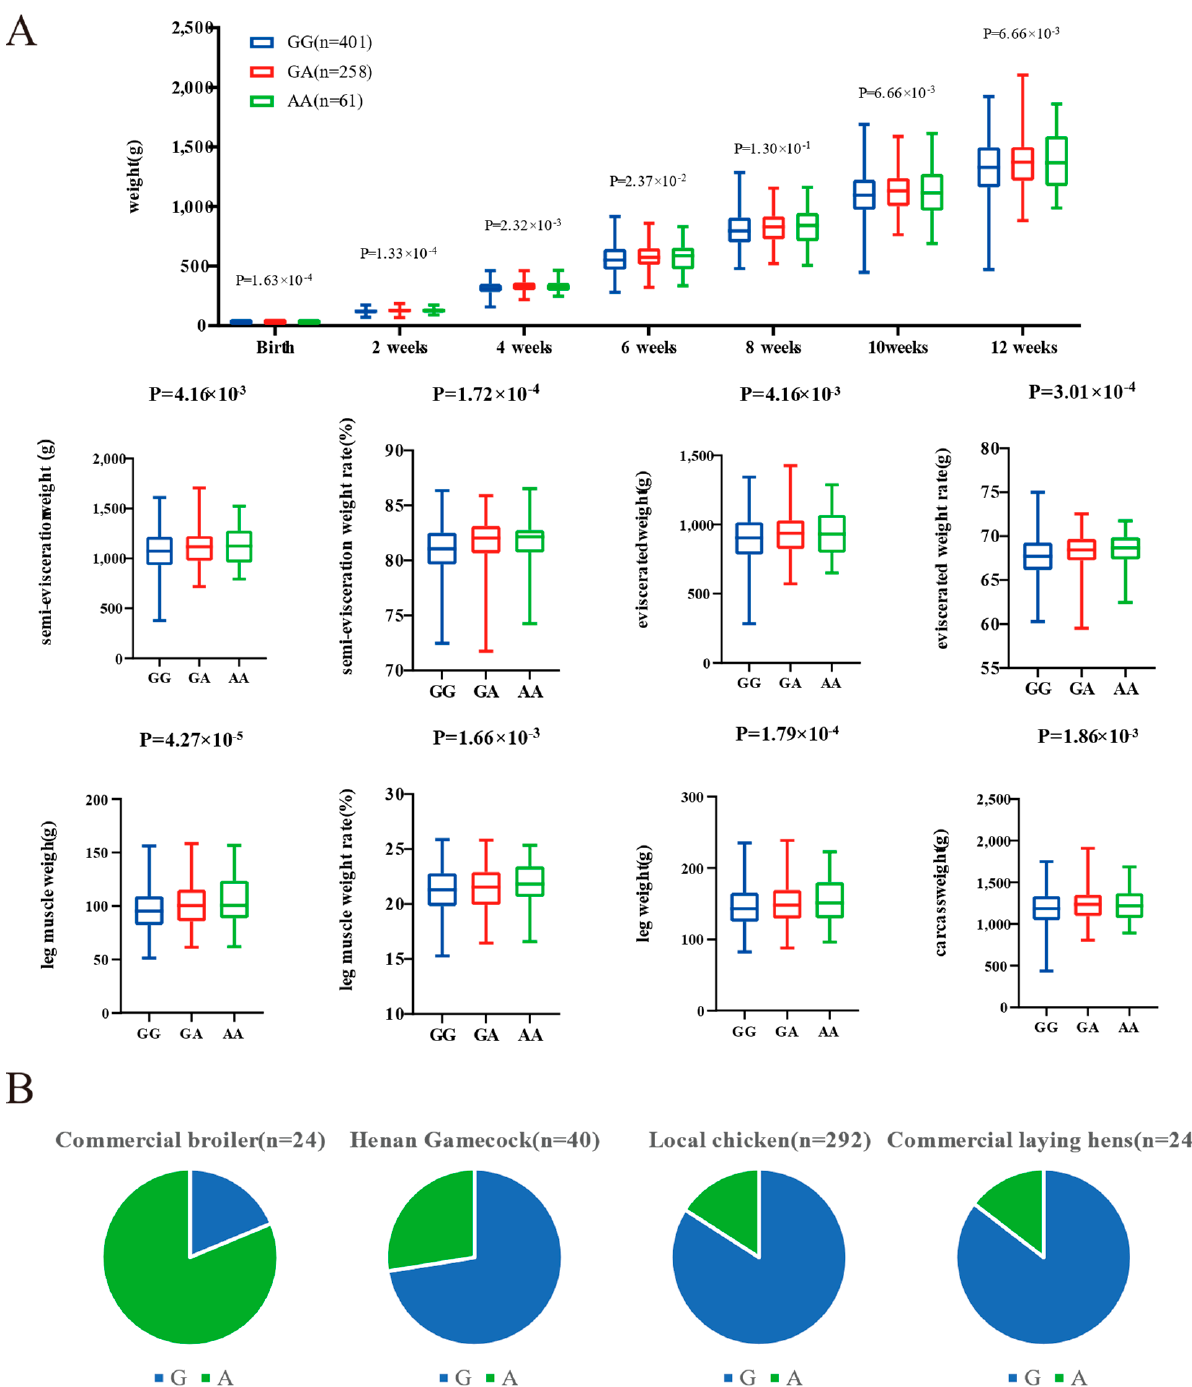
Figure 7. Genotype association of SNP Chr4: 75,859,000G>A in LCORL with body weight (BW) and carcass traits in Gushi-Anka F2 chickens ( A ), and the allelic frequency in different breeds ( B ).